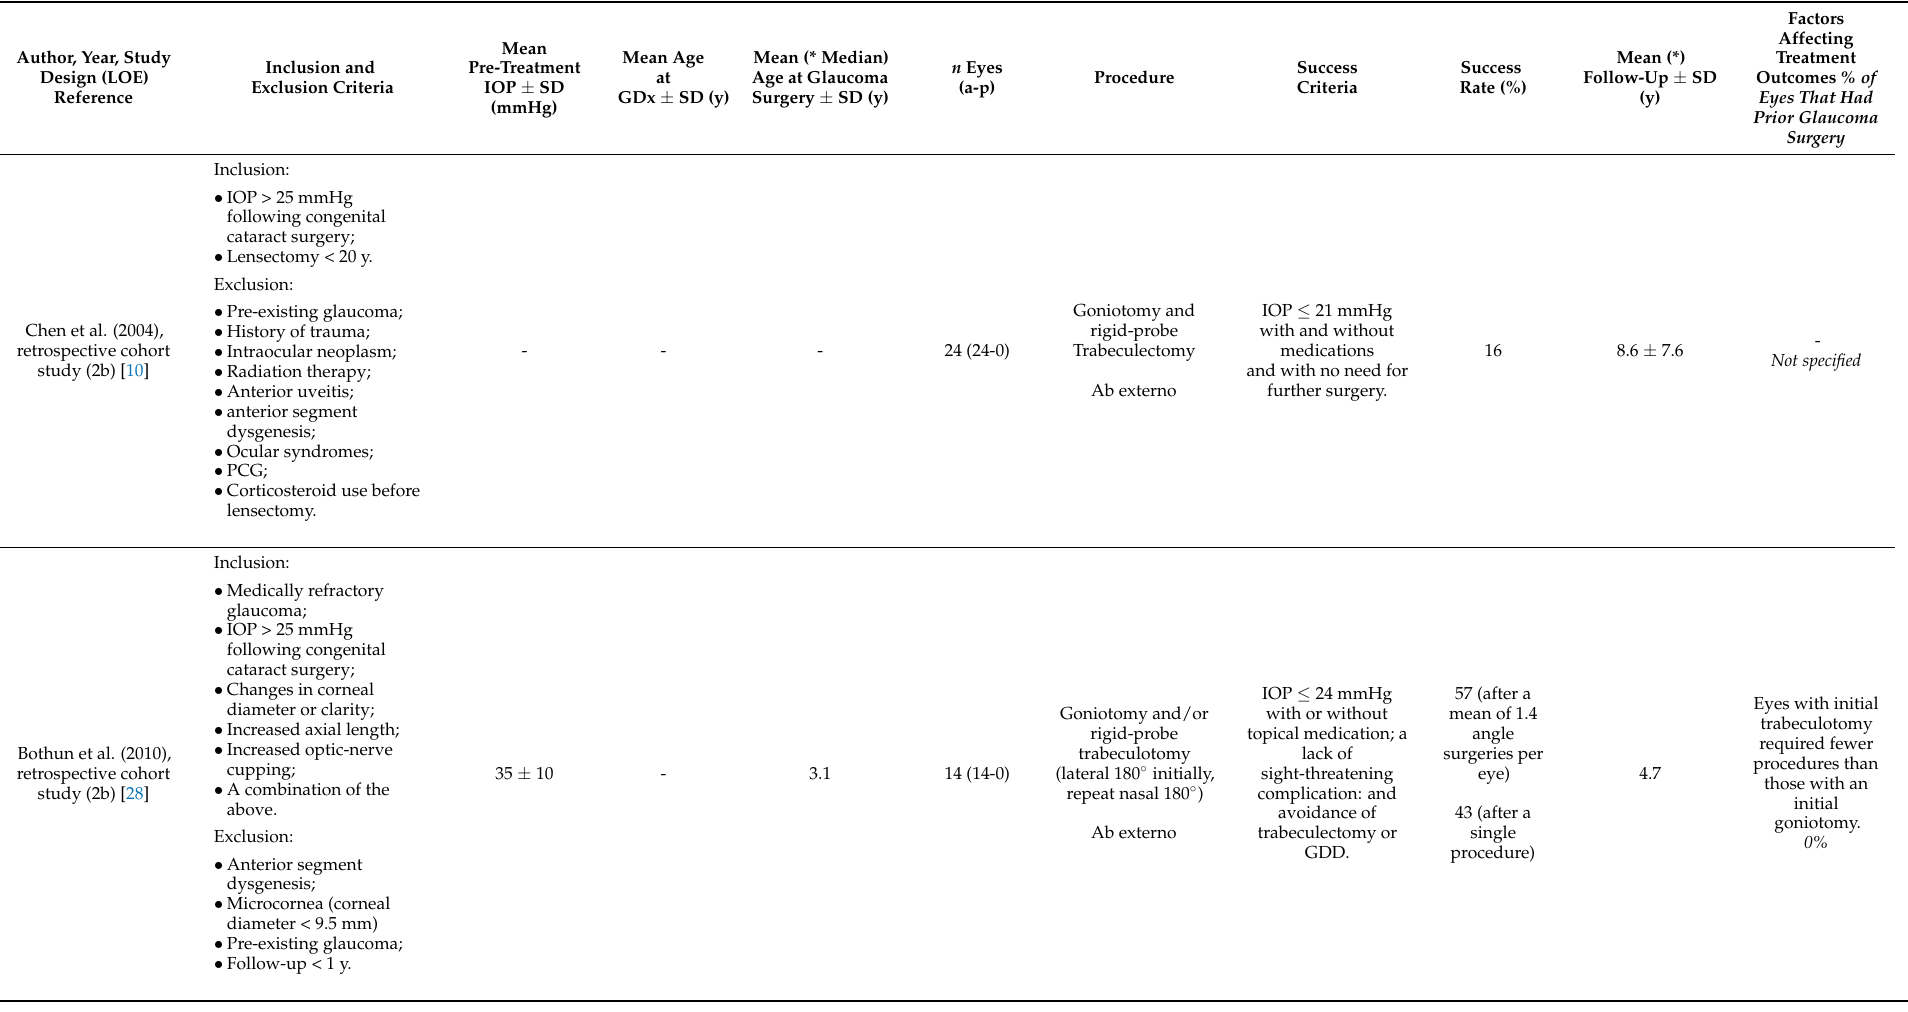
Table 2. Relevant studies involving angle surgery in GFCS